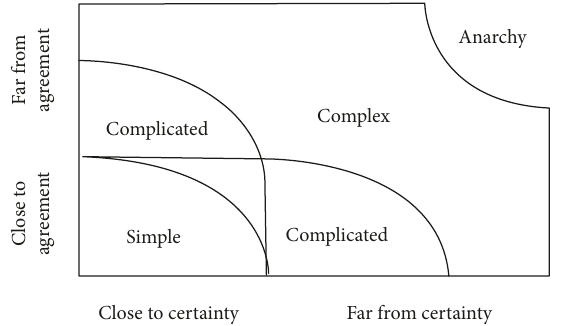
Figure 2: Agreement and certainty matrix